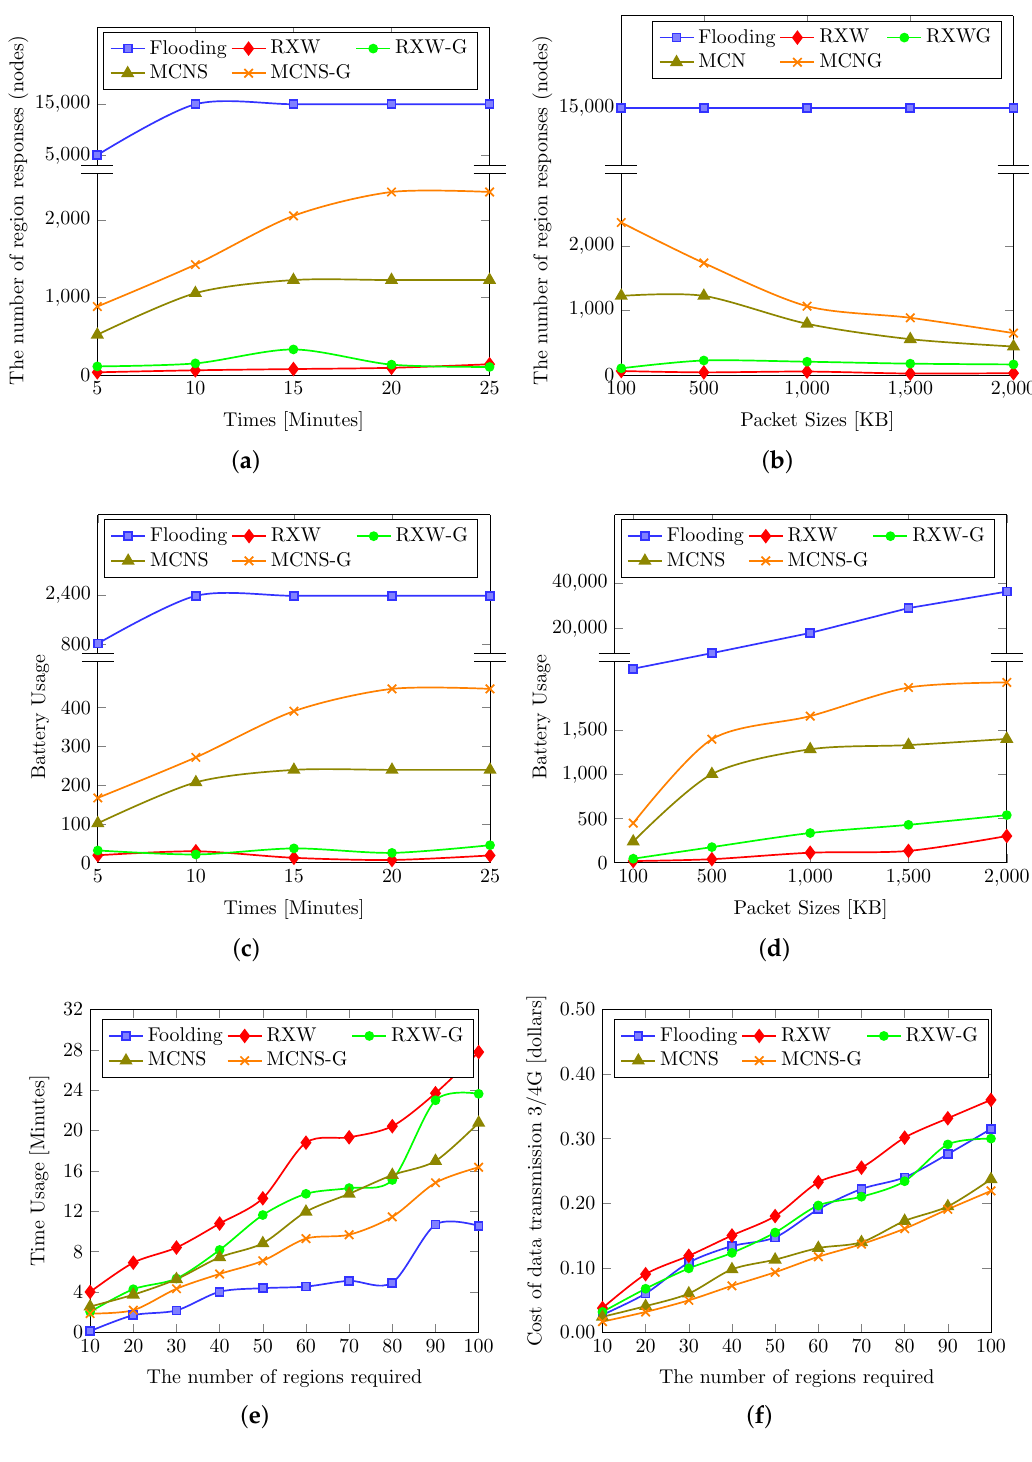
Figure 4. The comparison among five different approaches including (1) flooding, (2) Random-X-Walker (RXW), (3) Random-X-Walker with γ (RXW-G), (4) Multi-criteria Neighbor Selection (MCNS) and (5) Multi-criteria Neighbor Selection with γ (MCNS-G) in varying metrics including peer/region responses, energy consumption, query costs and time usage. ( a ) The relationship between the